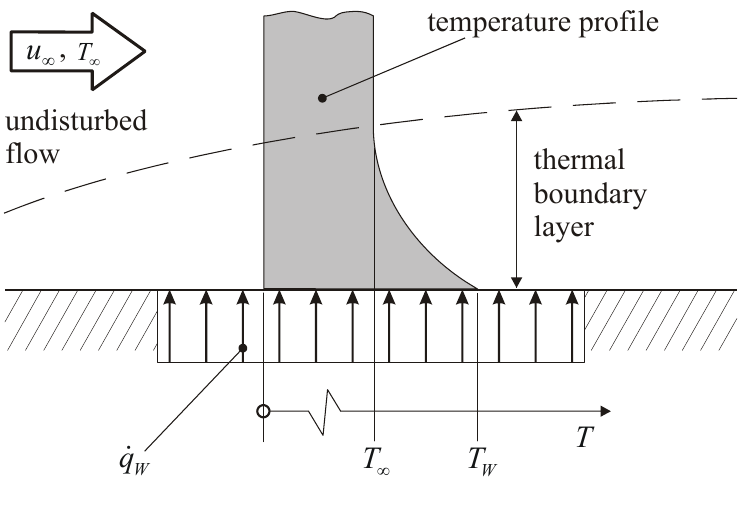
Figure 2. Part of a geometry with heat transfer to the adjacent